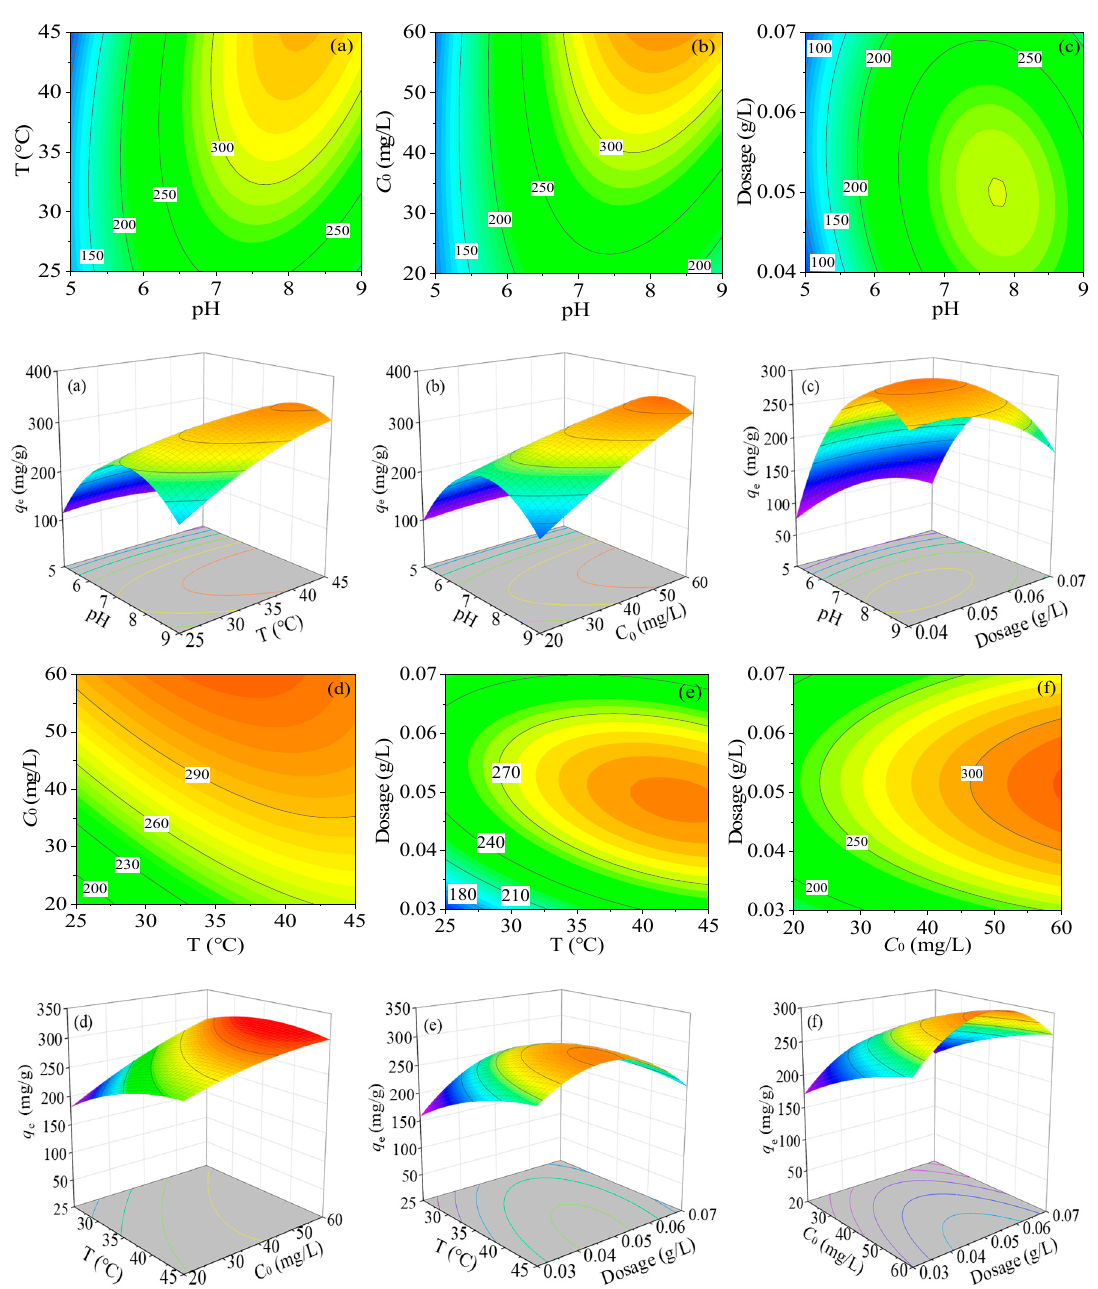
Figure 10. Three-dimensional (3D) relationship between variables and q e . (pH and temperature ( a ); pH and C 0 ( b ); pH and dosage ( c ); temperature and C 0 ( d ); temperature and dosage ( e ) and C 0 and dosage ( f )).